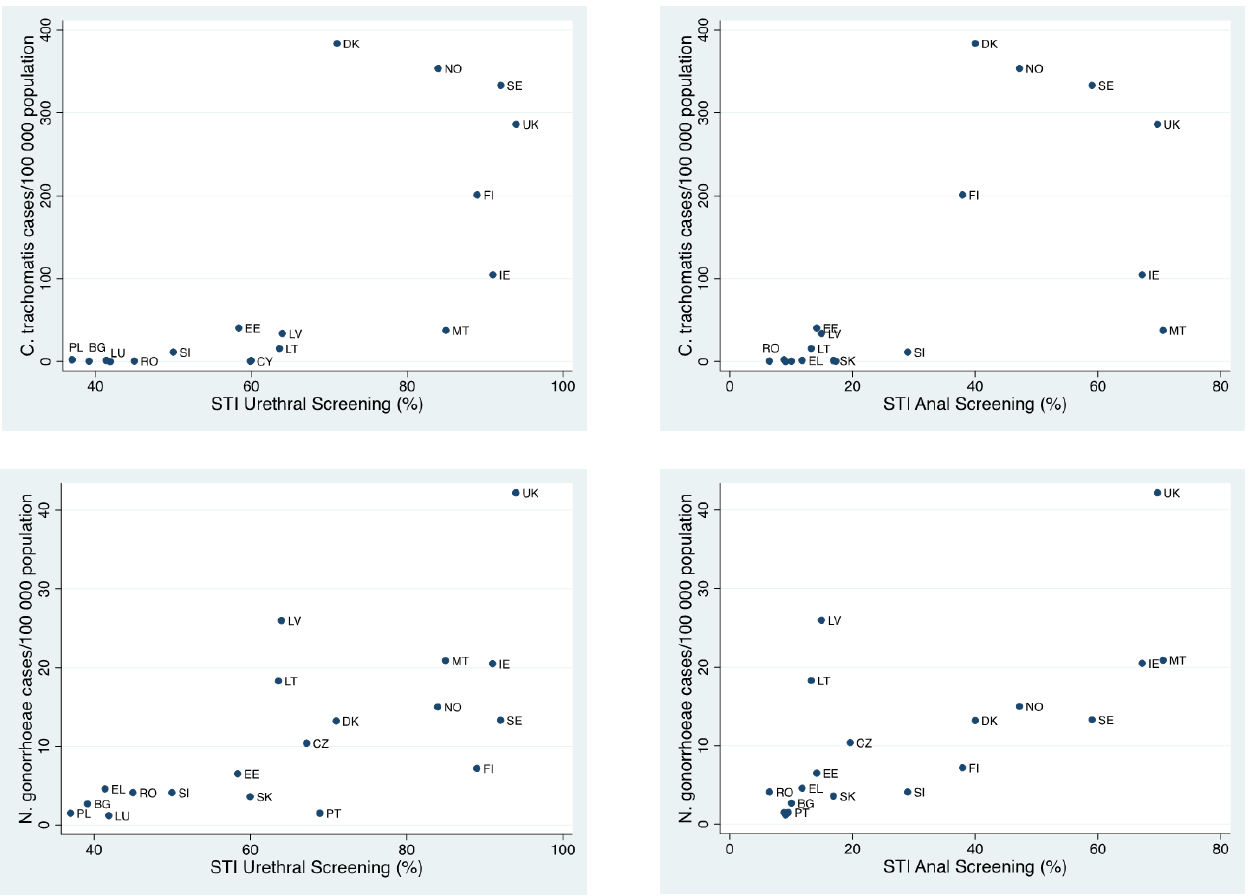
Figure 1. Scatter plots of country-level association between self-reported anal and urethral sexual transmitted infection (STI) screening intensity in men who have sex with men (MSM) and incidence of Chlamydia trachomatis and Neisseria gonorrhoeae in men in European countries in 2010. Country designations: AT, Austria; BE, Belgium; CZ, Czech Republic; DE, Germany; DK, Denmark; EL, Greece; ES, Spain; FI, Finland; FR, France; HR, Croatia; HU, Hungary; IE, Ireland; IT, Italy; LU, Luxembourg; LV, Latvia; NL, the Netherlands; PT, Portugal; SE, Sweden; SI, Slovenia; SK, Slovakia; UK, United Kingdom.